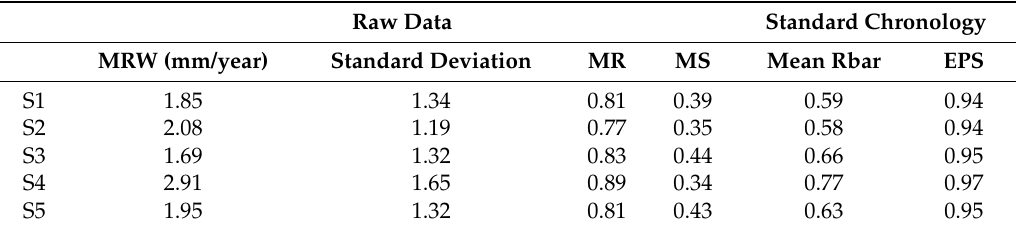
Table 2. Tree ring statistics.